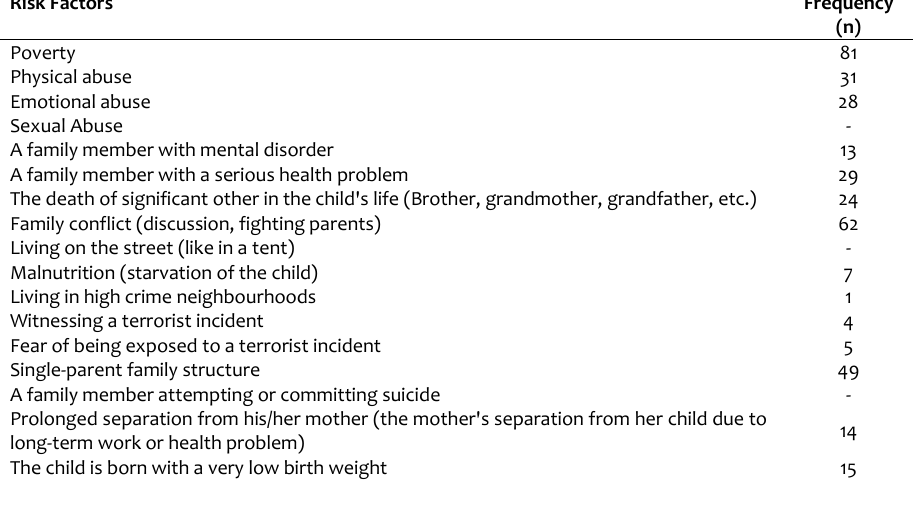
Table 1. Frequency Distribution of Risk Factors of the Children in the Study Risk